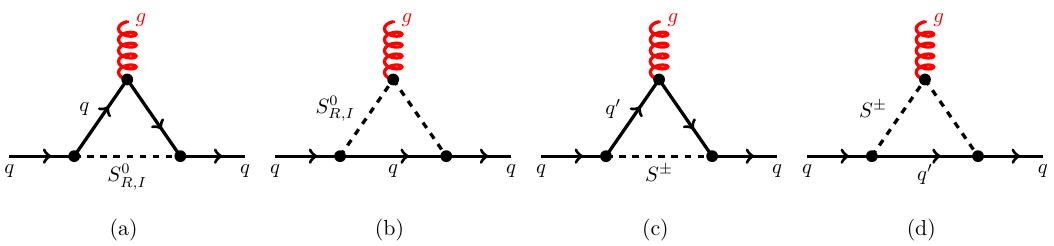
Figure 2 . Neutral S 0 and charged S ± scalars contributing to the CEDM of a quark q .